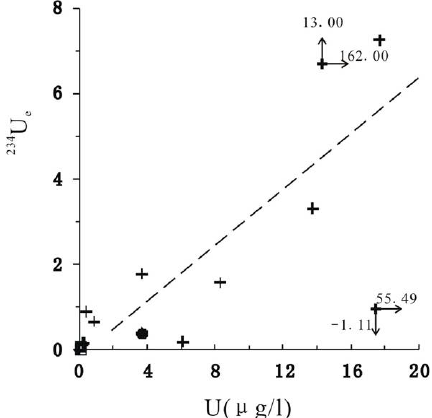
Figure 5. 234 U excess ( 234 Ue) as a function of U concentration in parts per billion , by weight, for the spring 1 waters (samples 1 ), groundwaters (samples 2–18) and lake water (sample 19) from the Shihongtan U ore district flow system. Drawn from the data in Table 1. Symbols as in Figure 3. Arrows indicate maximum and minimum values for data points that plot off scale.